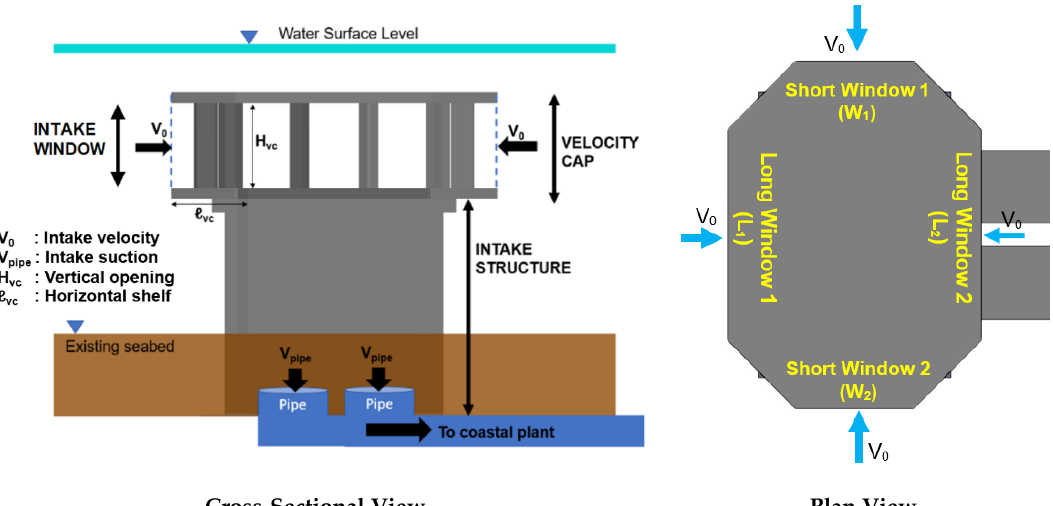
Figure 2. Schematic illustration of the flow in intake structure with velocity cap.